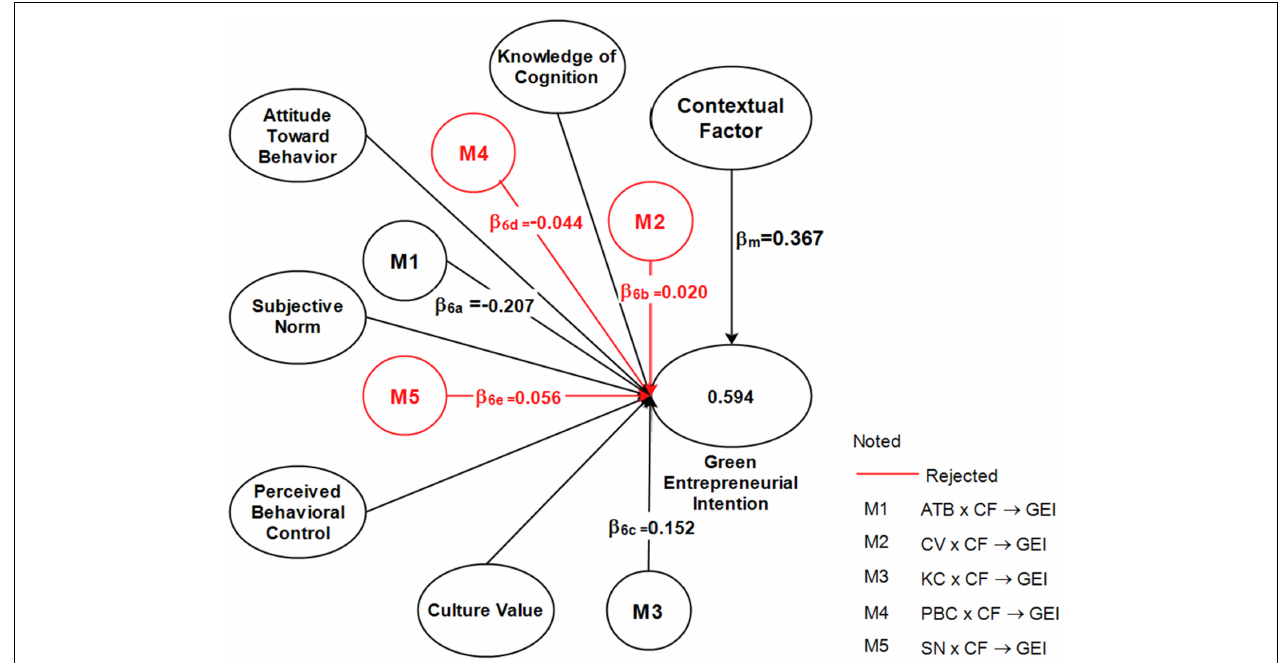
FIGURE 3 | Structural model—moderating effect.